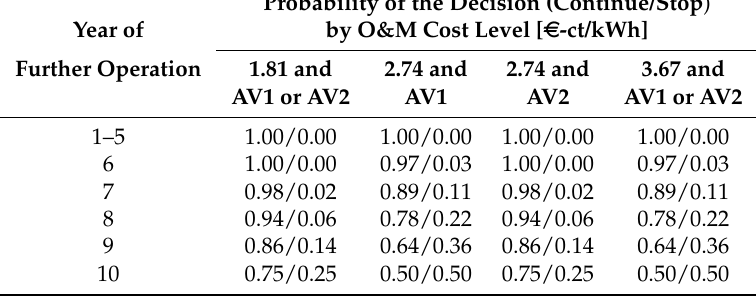
Table 6. Probability of the continuation or abandonment for all onshore wind power plants analyzed over the next 10 years after EEG levy expiration (AV—abandonment value equal to 80 e /kW; AV2—abandonment value equal to 5% of new investment